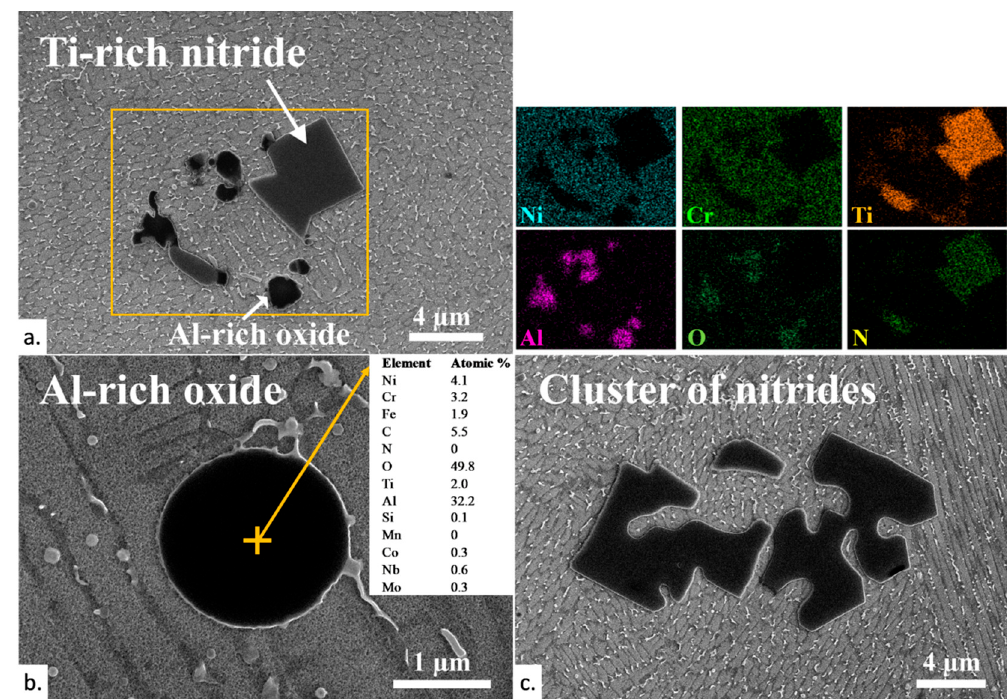
Figure 1. Typically observed inclusions observed on the etched cross-sections of the as-built Alloy 718, regardless of the atmosphere type and purity. ( a ) Titanium nitride and Al-rich oxides observed on the cross-section of a cube built under argon with 50 ppm residual oxygen. ( b ) A spherical Al-rich oxide observed on a cube built under nitrogen with 500 ppm residual oxygen. ( c ) Cluster of nitrides observed on the same cube.